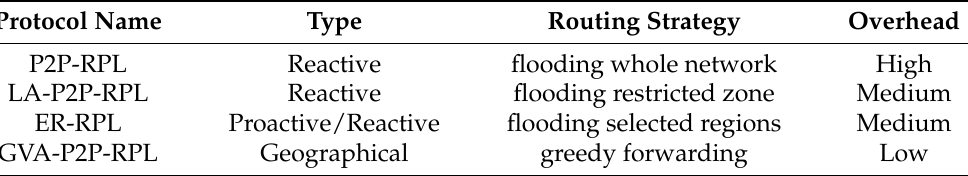
Table 1. Comparison of RPL-based P2P routing protocols for